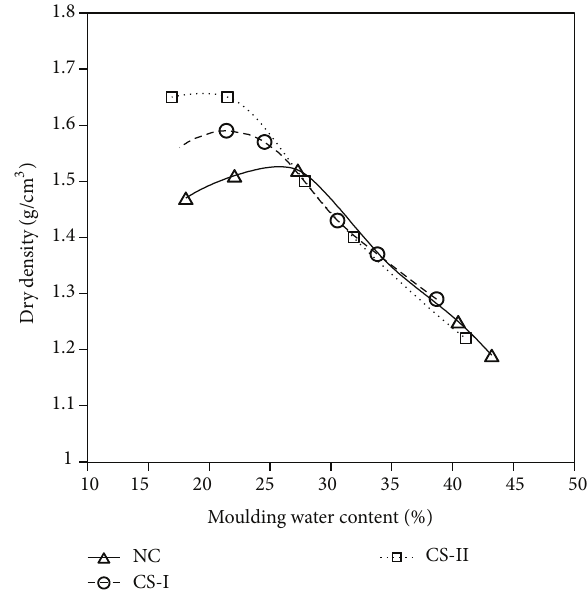
Figure 2: Compaction characteristics for the investigated